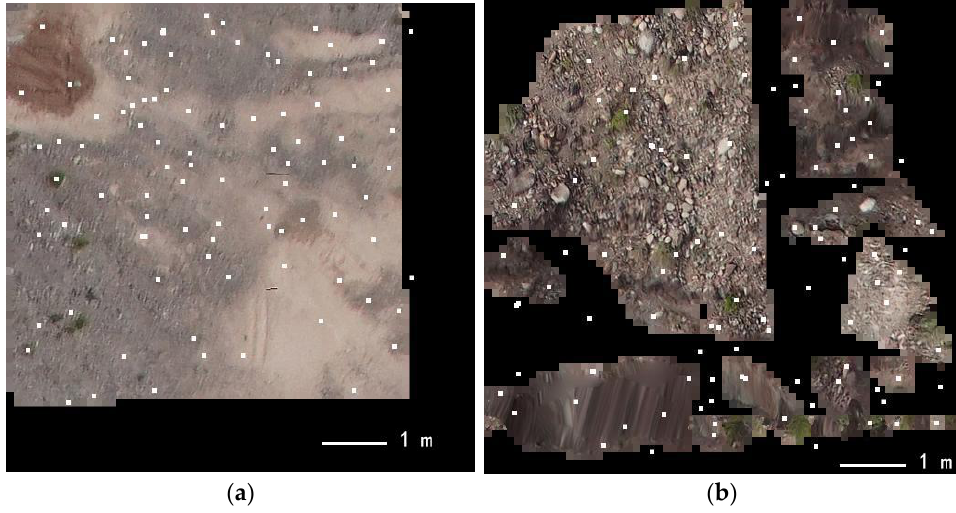
Figure 8. The distribution of feature points in texture images. ( a ) A continuous texture image. ( b ) A fragmented texture image.